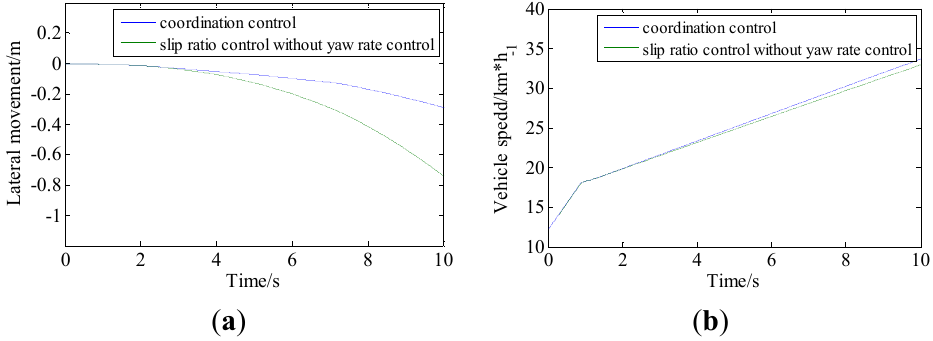
Figure 11. Comparison of simulation results of proposed strategy and normal strategy on variation friction coefficient road: ( a ) lateral movement and ( b ) acceleration